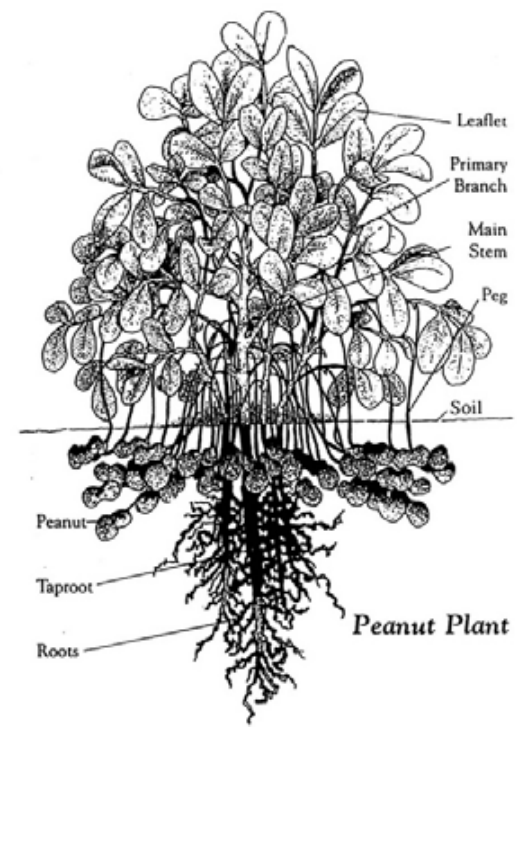
Figure 1: Groundnut plant Why grow